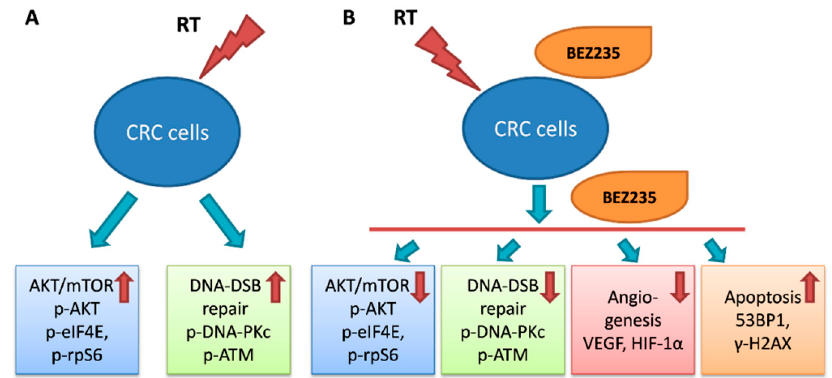
Figure 7. Maintenance BEZ235 treatment after BEZ235 combined with radiation treatment reduced cell viability and inhibited tumor growth in a colorectal cancer cell model. ( A ) Although